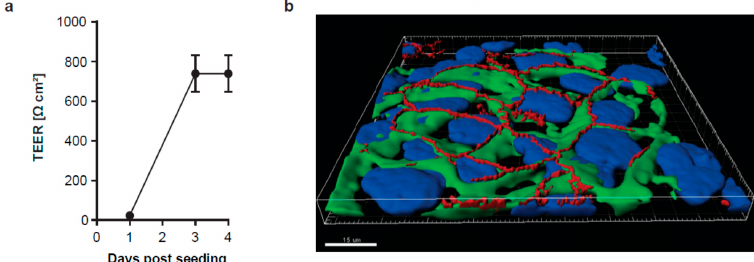
Figure 1. Establishment of polarized monolayers of the airway epithelial cell line Calu-3 cultured on semipermeable supports. ( a ) Transepithelial electrical resistance (TEER) was measured over the 4 days culture period. ( b ) 3D confocal microscopy image of polarized Calu-3 cells. To evaluate cell differentiation and polarization, the tight junction-associated protein ZO-1 (red signal) at the apical surface and the basolateral marker β -catenin (green signal) were immunostained. Nuclei were visualized with DAPI. Note the honeycomb-like ZO-1 pattern. Scale bar, 15 µm. We first tested whether treatment with any of the drugs—single or combined—affected cell survival. In line with their clinical use, neither oseltamivir nor itraconazole alone had an impact on